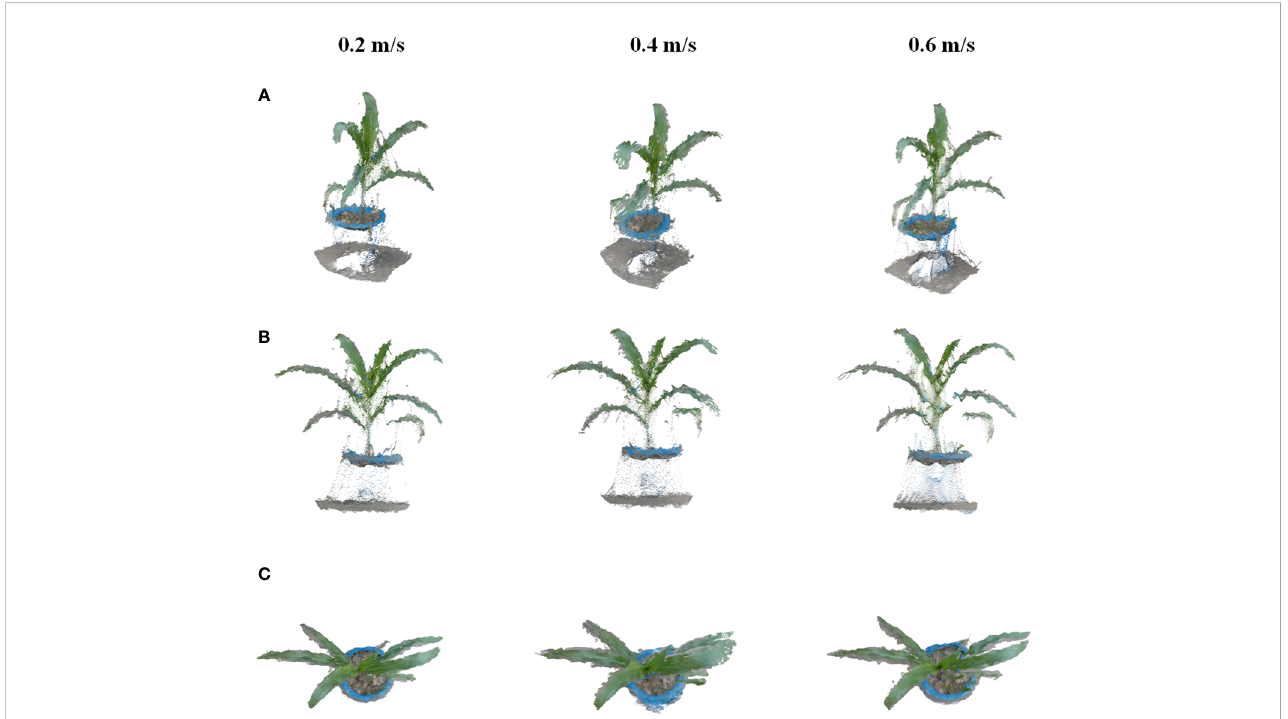
FIGURE 6 Results of dynamic reconstruction for corn at speeds of 0.2 m/s, 0.4 m/s, and 0.6 m/s. (A – C) are different views of single crop reconstruction in plant rows with different